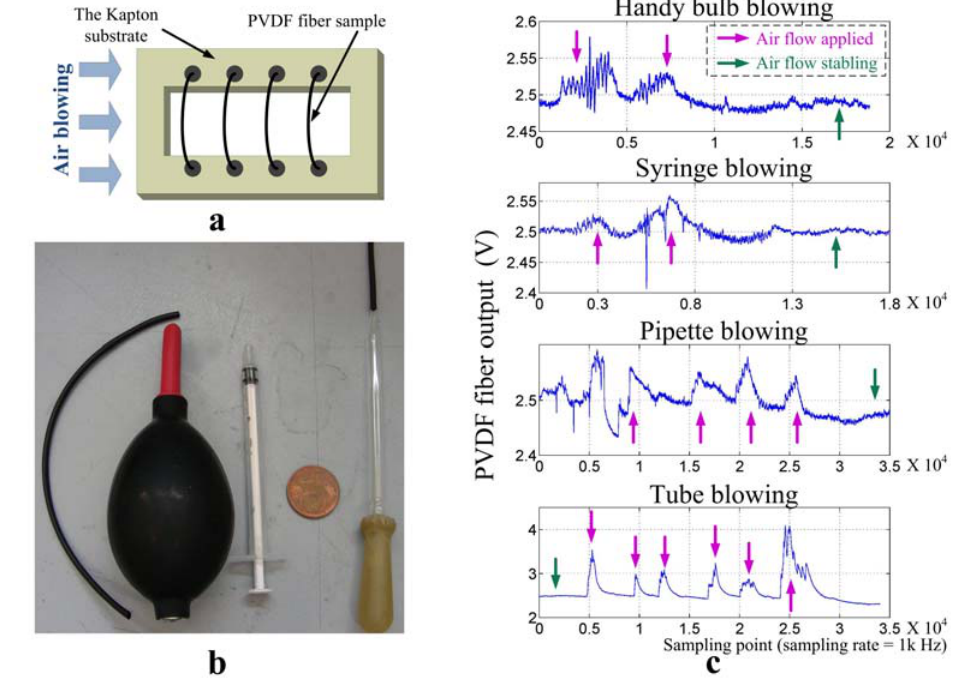
Figure 14. Setup and results of blowing experiment; (a) Scheme of blowing experiments, (b) local blowing tools (the 2 mm inner diameter plastic tube, handy bulb, 1 ml syringe, a comparison coin and a normal micropipette from left to right respectively), (c) fiber response to the blowing by the handy bulb, the 1 mL syringe, the micropipette and the tube from top to bottom